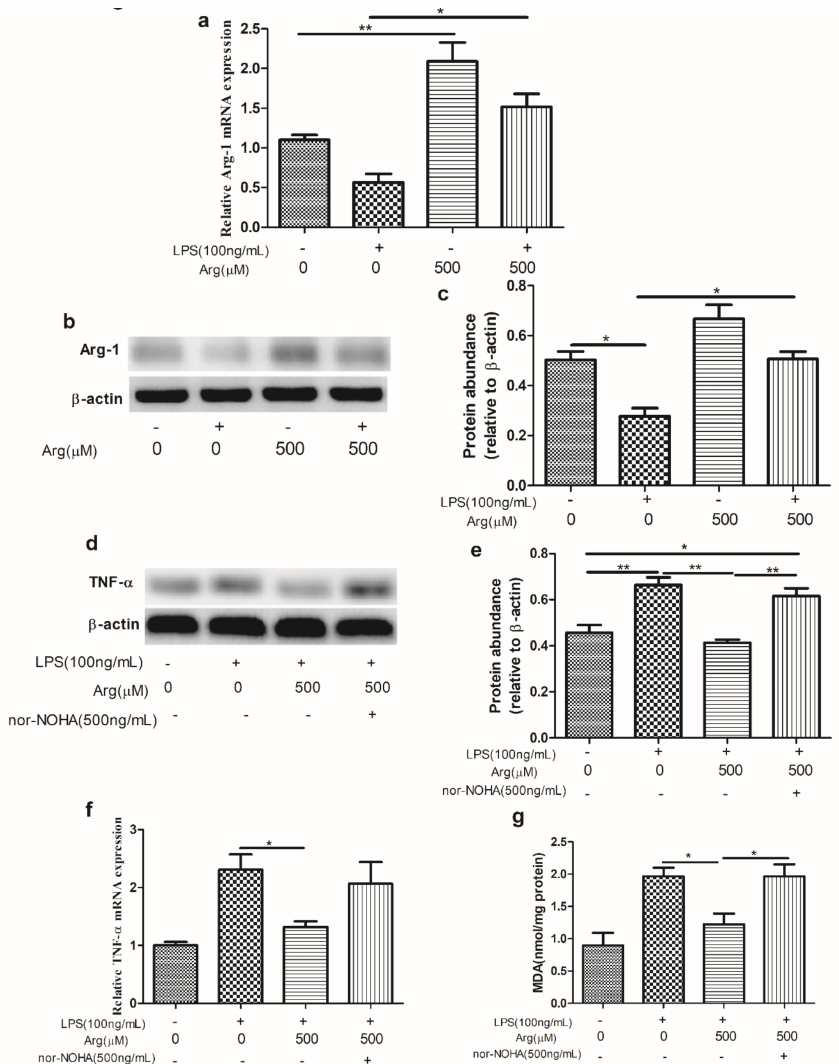
Figure 7. The protection of L-arginine against LPS-induced inflammatory response and oxidative stress via Arg-1 signaling. ( a ) the abundance of Arg-1 transcript; ( b ) the protein levels of Arg-1 was determined by Western blotting. Equal protein loading was confirmed by analysis of β -actin in the protein extracts; ( c ) the ratio of Arg-1 to β -actin in IPEC-J2 cells treated with LPS, L-arginine, or both. ( d ) The protein levels of TNF- α was determined by Western blotting. Equal protein loading was confirmed by analysis of β -actin in the protein extracts; ( e ) the ratio of Arg-1 to β -actin; ( f ) the abundance of TNF- α transcript; ( g ) the content of MDA in IPEC-J2 cells treated with LPS (0 or 100 ng / mL) and LPS-treated cells were co-incubated with L-arginine or L-arginine together with Arg-1 inhibitor. Data were representative of triplicate experiments and expressed as the mean ± SEM. * p < 0.05, ** p < 0.01. Arg-1,